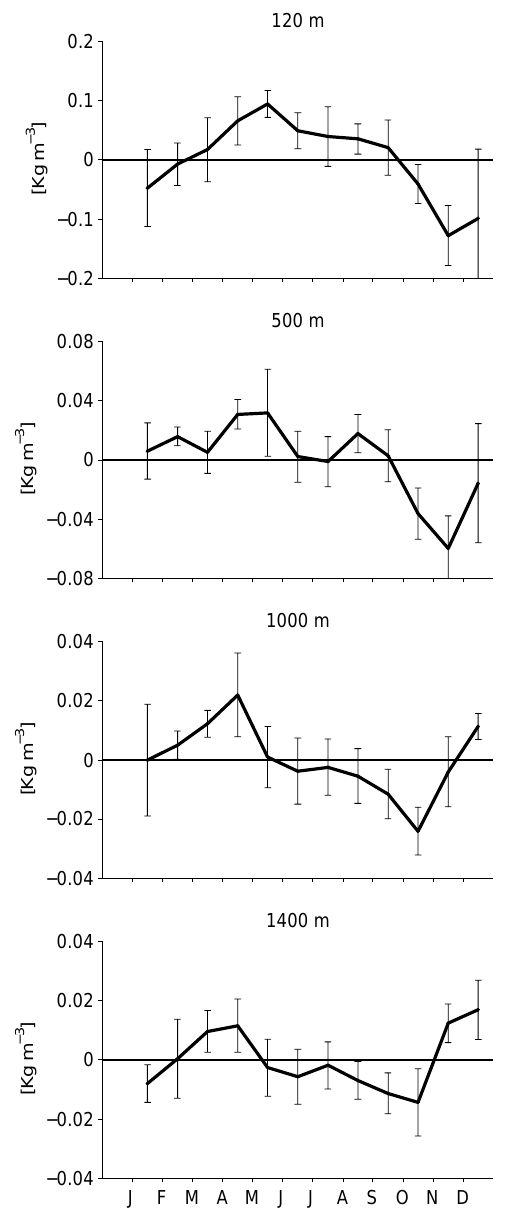
Fig. 14. Monthly-mean in-situ density anomaly at EBH at selected depths. The bars indicate standard deviations of the monthly means. Note the change of the density scale.